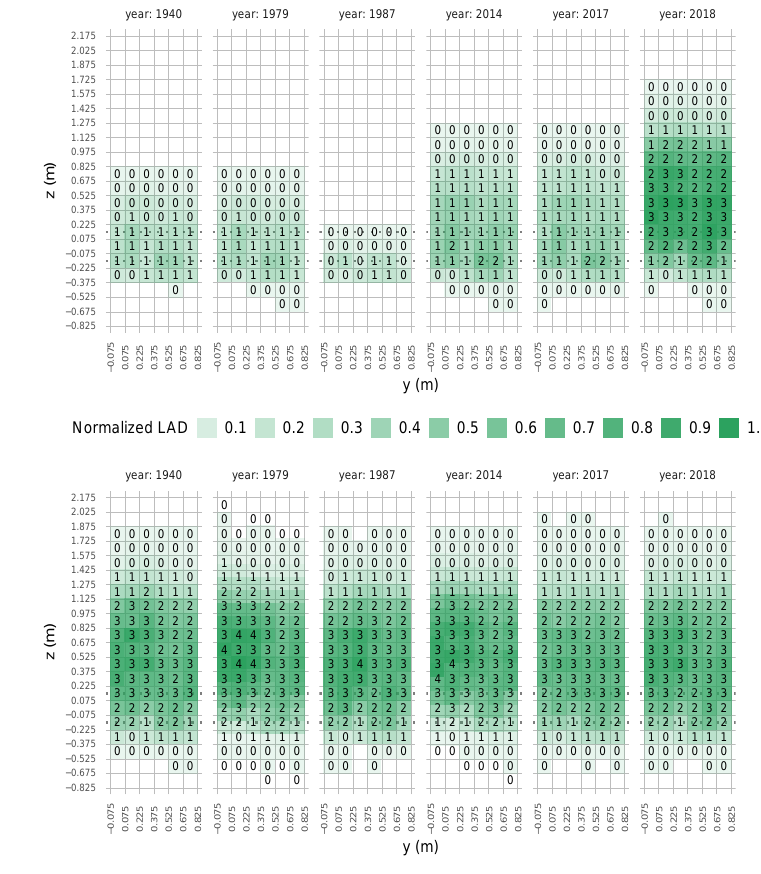
Figure 18. Differences in leaf area density (LAD, m 2 m − 3 ) for cuboids of 0.050625m 3 (195cm × 15cm × 15cm) caused by bud burst date and temperatures after bud burst: ( A ) at DOY 173 per year ( n 2018 = 653, n else = 2000); and ( B ) for averages at the end of simulation per year ( n = 2000). Opacity: normalised LAD (LAD/ max ( LAD ) . Side view of canopy: cane/canopy aligned with y -axis; y : distance along cane/canopy; z : height relative to centre of bunch zone; dotted line: bunch zone.